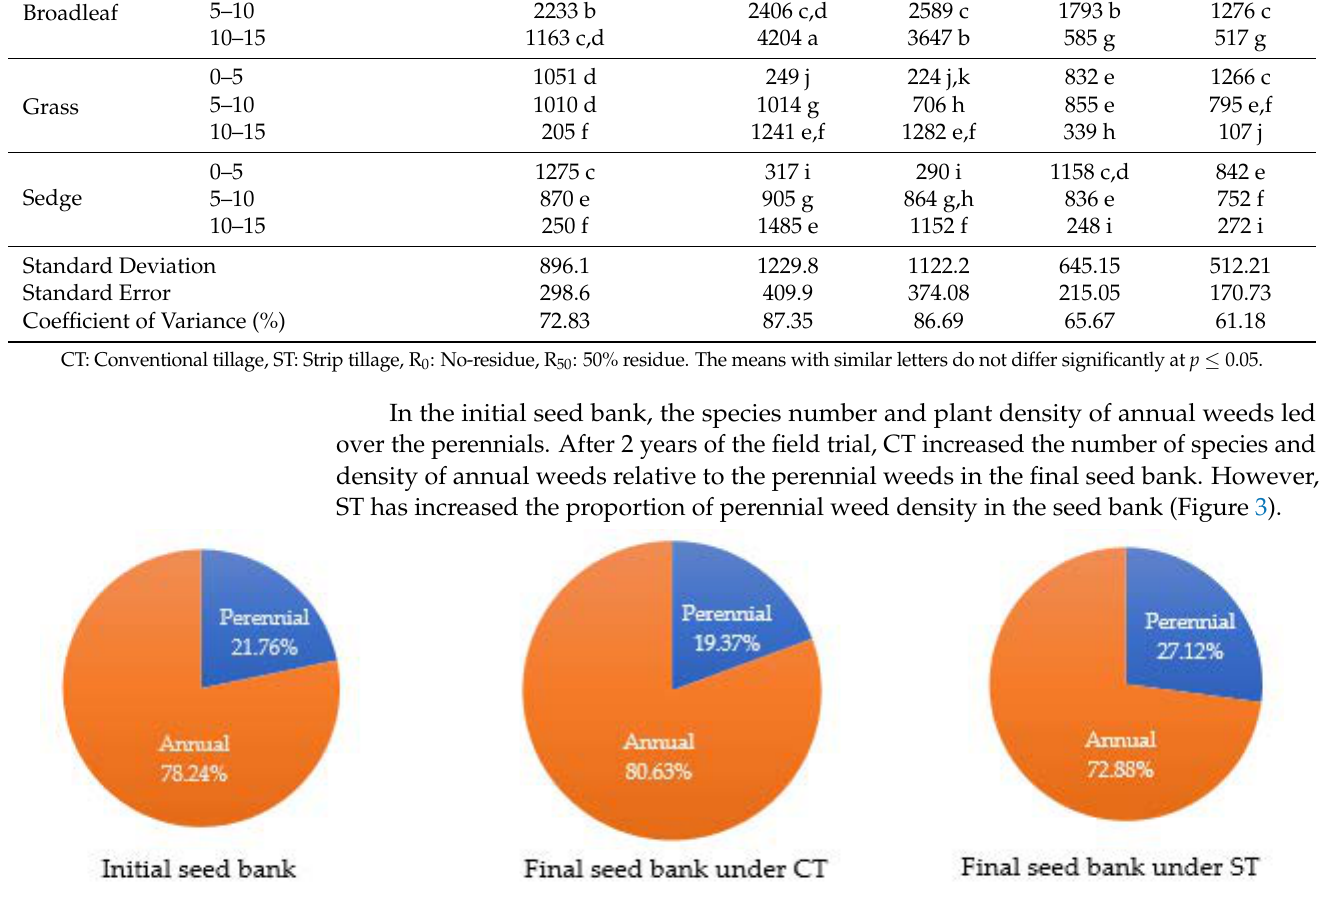
Figure 3. Percentage of annual and perennial weed species in the weed communities under different tillage systems (average for the depths and